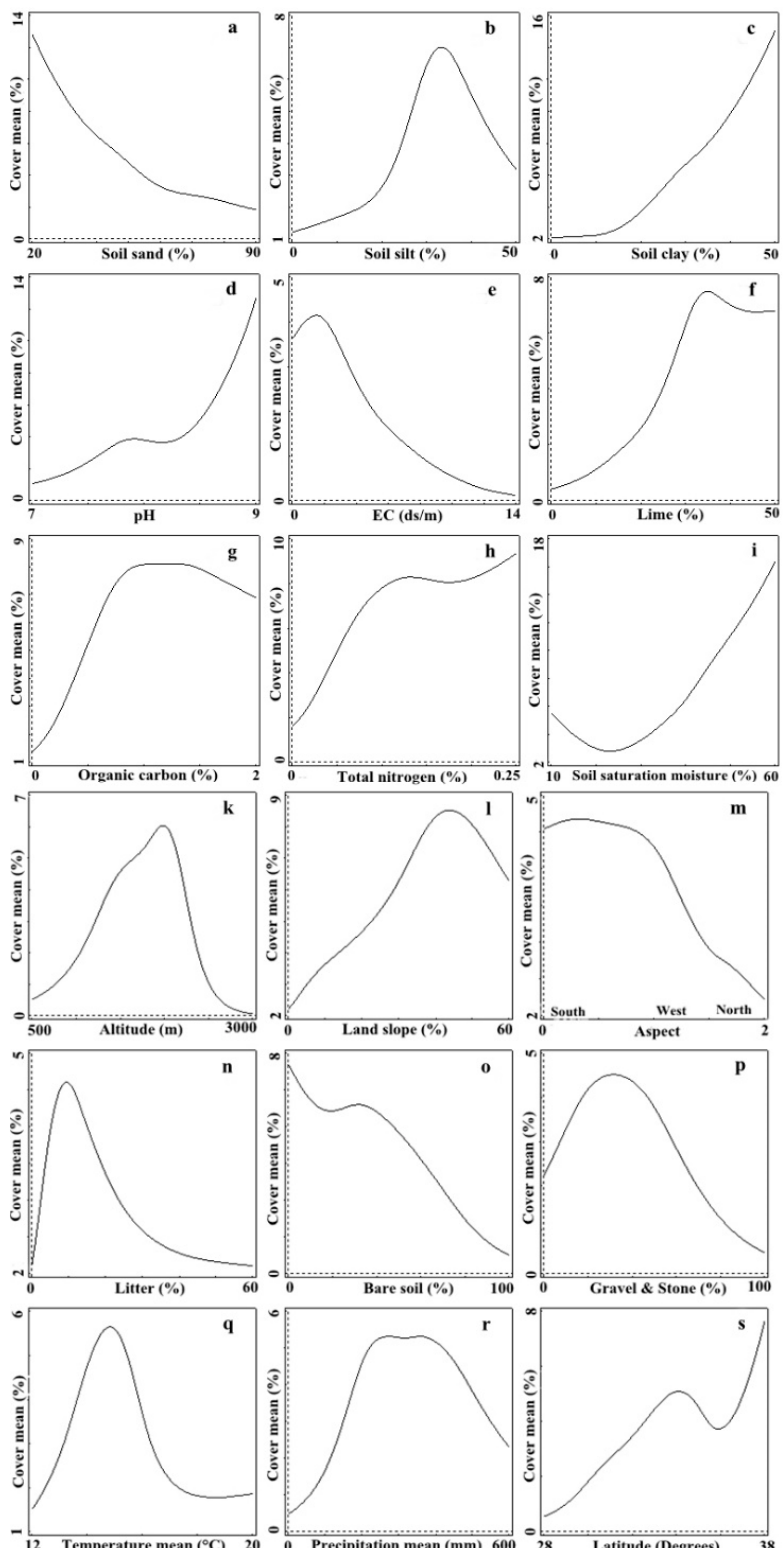
Figure 2. A. sieberi responses along the gradient of environmental factors. The A. sieberi unimodal response to the soil silt (Figure 2b), altitude (Figure 2k), land slope (Figure 2l), gravel and stone (Figure 2p), litter (Figure 2n), temperature (Figure 2q)